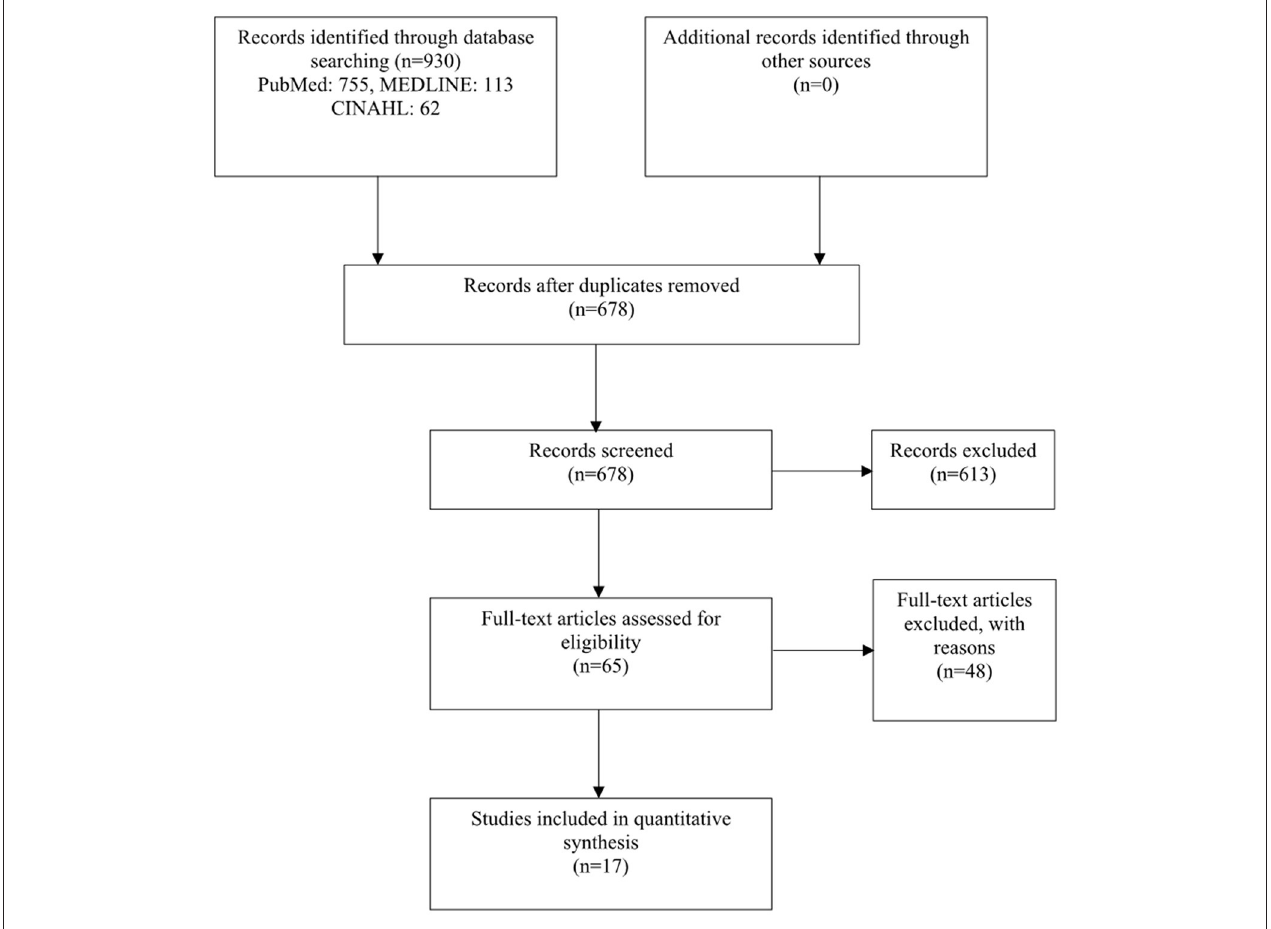
FIGURE 1 | Flowchart of the study selection.